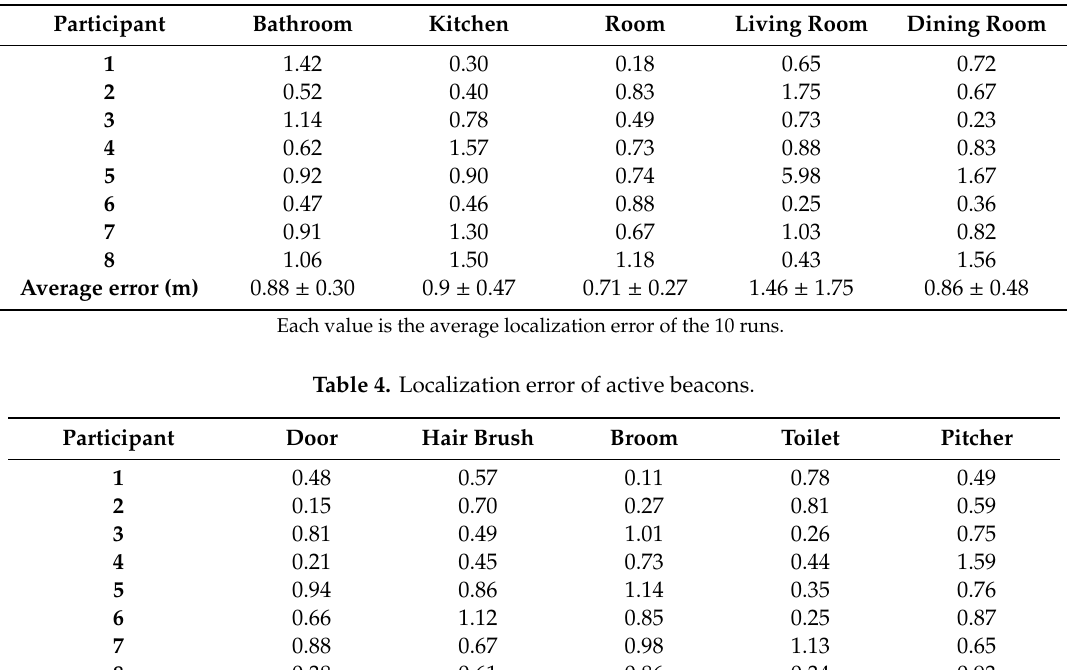
Table 3. Localization error of stationary beacons.